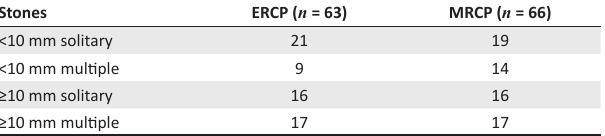
FIGURE 1: Seventy-year-old man with <10 mm choledocholithiasis (arrow) as imaged by (a) MRCP and (b) DWI, and (c) ERCP demonstrating a subcentimeter stone (arrow). TABLE 2: The distribution of stones according to the number and diameter of stones on endoscopic retrograde cholangiopancreatography and magnetic resonance